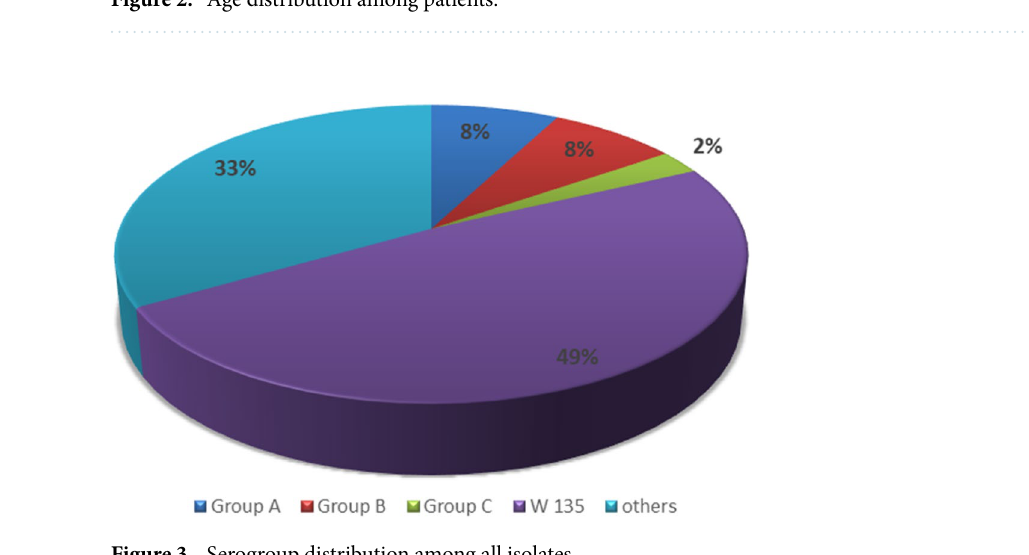
Figure 3. Serogroup distribution among all isolates.